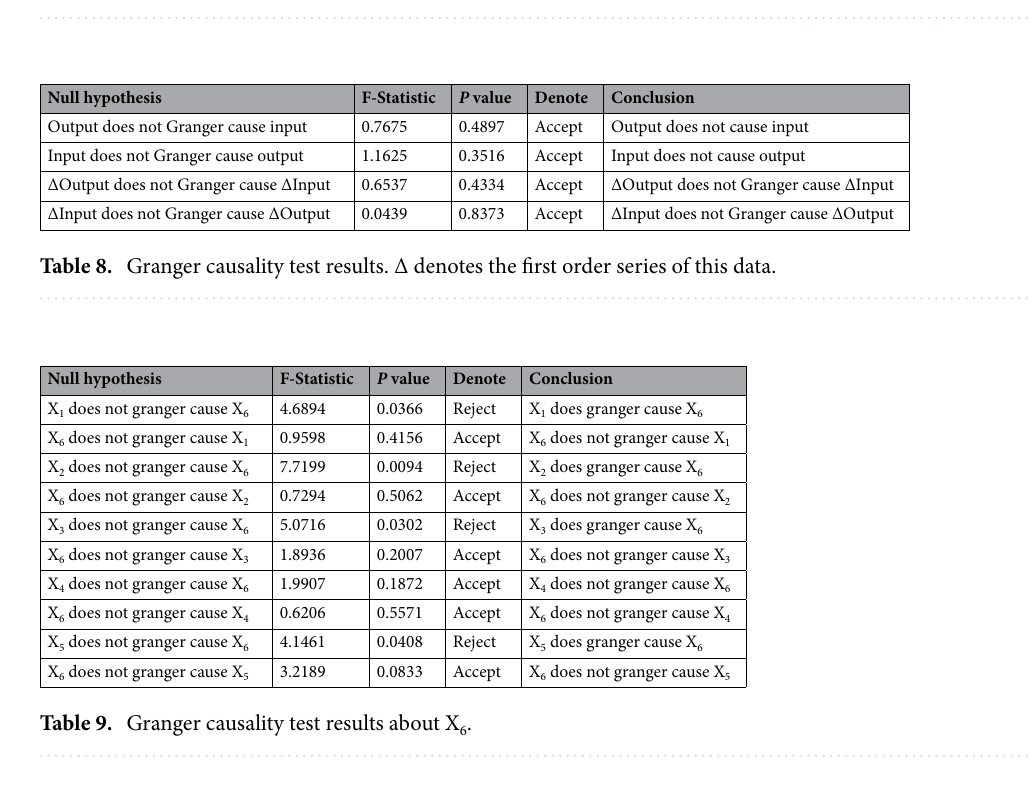
Table 7. Johansen cointegration test results. *denotes rejection of the hypothesis at the 0.05 level.